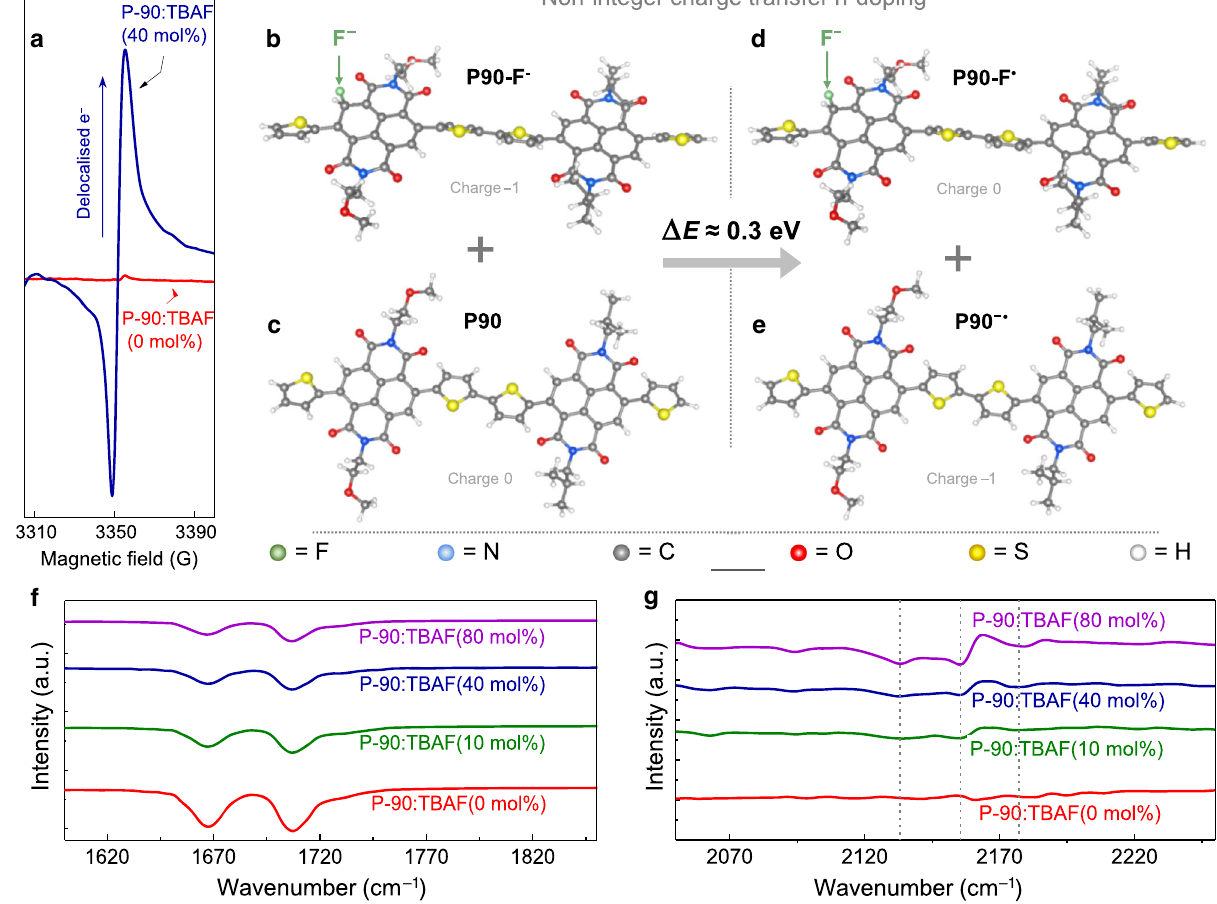
Fig. 2 TBAF as a molecular n-dopant. a Electron paramagnetic resonance (EPR) spectroscopy on pristine P-90:TBAF(0 mol%) and best-performing P-90: TBAF(40mol%). b – e TBAF doping mechanisms, calculated using density functional theory: ( b ) a fl uorinated P-90 dimer releases an electron to ( c ), an F-free P-90 dimer, by forming a ( d ) fl uorinated P-90 radical and ( e ) P-90 anion radical. The energy required for this process to happen ( Δ Ε ) is ≈ 0.3 eV, indicating an electron release could be activated for large concentrations of TBAF. f – g Fourier-transform infrared (FTIR) spectroscopy, shifted vertically for clarity: ( f ) symmetric and antisymmetric NDI unit C = O stretching, and ( g ) asymmetrical stretching of – N = C = O in NDI ring summary of key OECT operating, electrical and electrochemical parameters, showing that TBAF improves OECT characteristics,